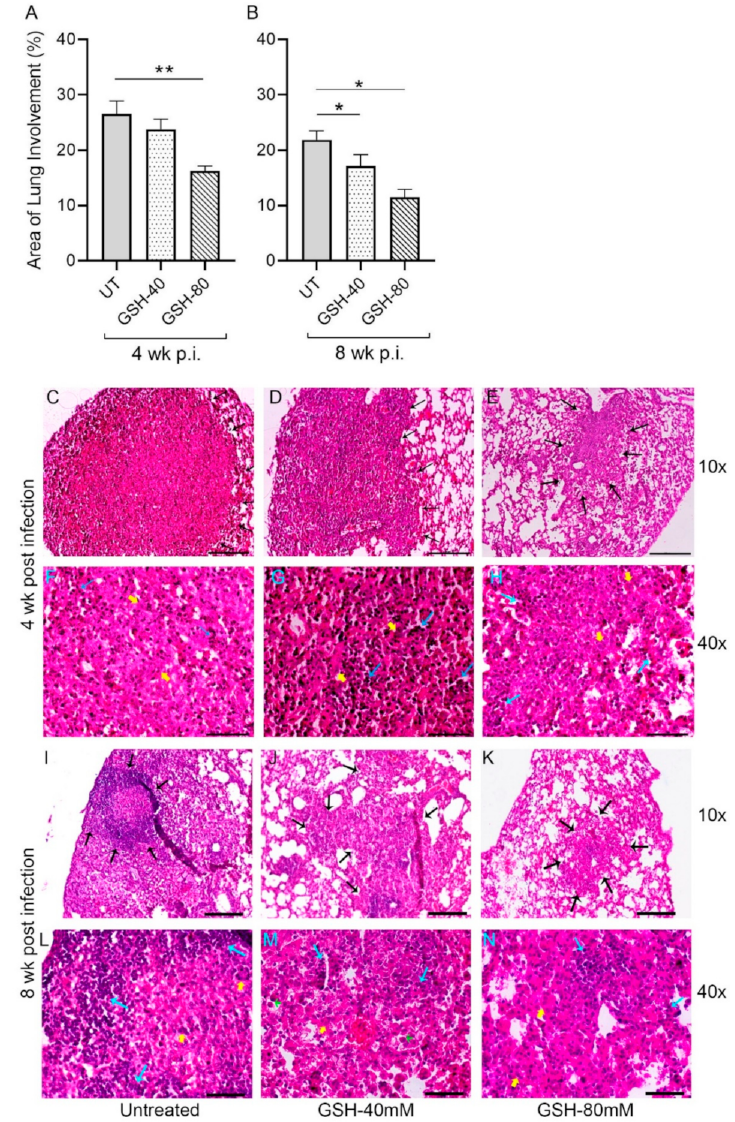
Figure 6. Morphometric analysis and histology of the lung granulomas in the M. tb -infected untreated and L-GSH-treated mice. The lung sections were collected from the M. tb -infected untreated mice and the 40 mM or 80 mM L-GSH-treated mice at 4 weeks ( A ) and 8 weeks ( B ) post-infection (p.i). All of the values plotted for each group represent the mean values +/ − standard deviation. One-way ANOVA with Tukey’s multiple group post correction was applied to determine the significance between the groups and a p -value of <0.05 (*) was considered significant. ** p < 0.01. Statistical analysis was performed using GraphPad Prism Software 8. The sample size is 6 mice (n = 6) per group, per time point. The lung histopathology was analyzed from the untreated and 40 mM or 80 mM L-GSH-treated mice at 4 weeks ( C – H ) and 8 weeks ( I – N ) post- M. tb infection (p.i.). The lung sections were stained with hematoxylin and eosin to visualize the presence of granulomas, inflammation, cell infiltration, and cellular aggregates with and without L-GSH treatment under bright field microscopy. The images were magnified at 10 × ( C – E , I – K ) and 40 × ( F – H , L – N ). The lung samples of the untreated ( C , F , I , L ) and 40 mM ( D , G , J , M ) or 80 mM ( I , H , K , N ) L-GSH-treated mice were analyzed blind-folded. The yellow arrows indicate the MNGCs, the black arrows demarcate the granulomatous area, blue arrows indicate lymphocytic cellular infiltrates, and green arrows (M) show neutrophils. The scale bars in ( C – E , I – K ) are 100 µ m, and the scale bars in ( F – H , L – N ) are 50 µ m. The images are representative of n = 6 per group, per time